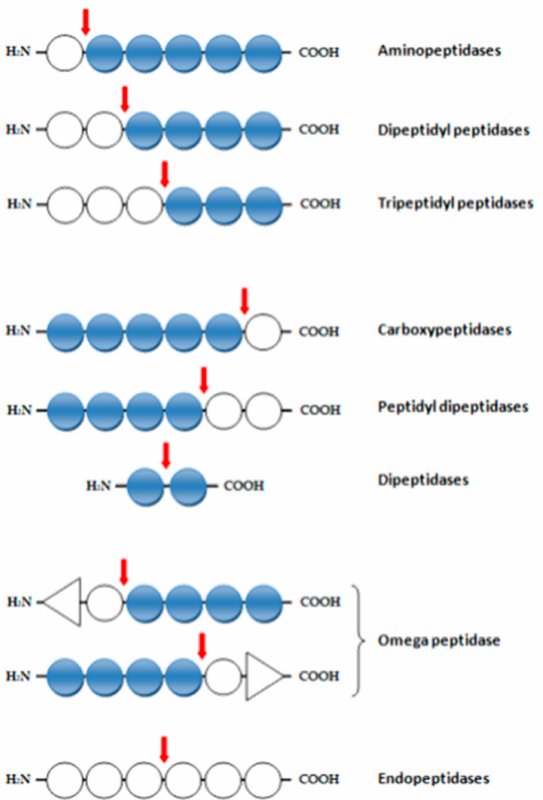
Figure 1. Classification of the activity of proteolytic enzymes. Arrows indicate the site of action of the enzyme. Triangles indicate blocked ends of the polypeptide chain. The white dots are the amino acid residues in the polypeptide chain. The blue dots are terminal amino